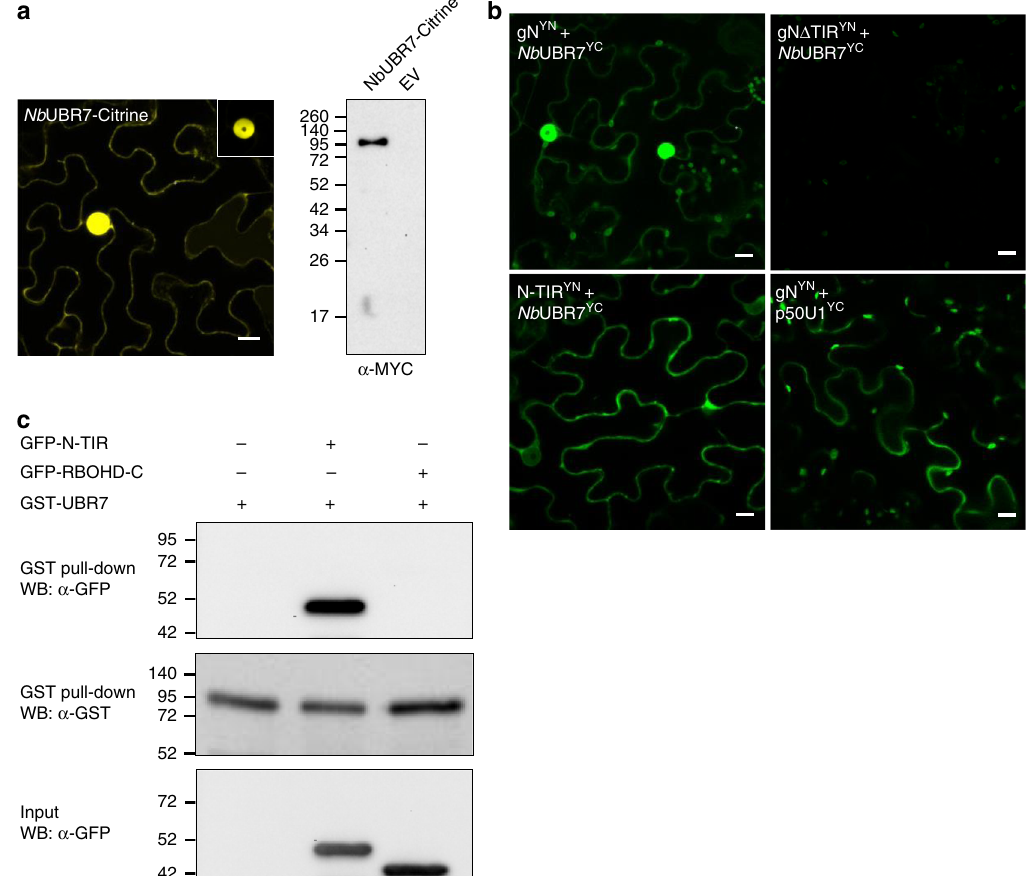
Fig. 4 Analysis of the interaction between N and Nb UBR7 in vivo and in vitro. a Subcellular localization of Nb UBR7. Nb UBR7 was fused to citrine ( Nb UBR7- citrine) followed by agroin fi ltration. Confocal analysis was performed at 2 dpi. NbUBR7 is present in the cytoplasm and in the nucleus (left panel). The rectangular region on top right of the image indicated a lower gain value image to con fi rm the nuclear localization of Nb UBR7. Scale bar represents 10 µ m. NbUBR7 expression was con fi rmed by western blot analysis using antibodies against MYC tag (right panel). Empty vector served as the control. The molecular weight size markers in kDa are indicated at the left. b BiFC analysis of the interaction between Nb UBR7 and N as well as its different domains. Nb UBR7 fused to C-terminus of citrine ( Nb UBR7 YC ) was coexpressed with native promoter-driven full-length N (gN), TIR domain deleted N (gN Δ TIR) or TIR domain alone (N-TIR) fused to N-terminus of citrine in the N. benthamiana leaves. Confocal analysis was performed at 2 dpi. gN YN and p50U1 YC served as the positive control. Scale bars = 10 µ m. c In vitro GST-pull down assay to examine the interaction between Nb UBR7 and the TIR domain of N. The puri fi ed GFP-tagged TIR domain of N or C-terminal region of the respiratory burst oxidase homolog D (RBOHD) were incubated with GST-tagged Nb